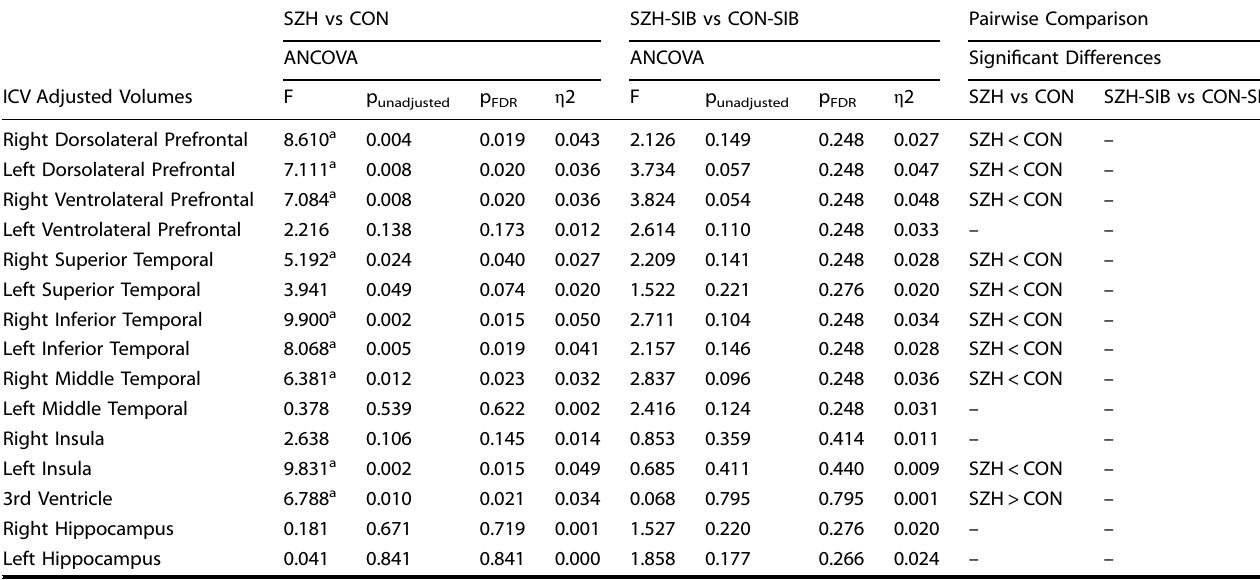
Table 2. Group Differences in ICV-Adjusted Volumes (age and gender as covariates).